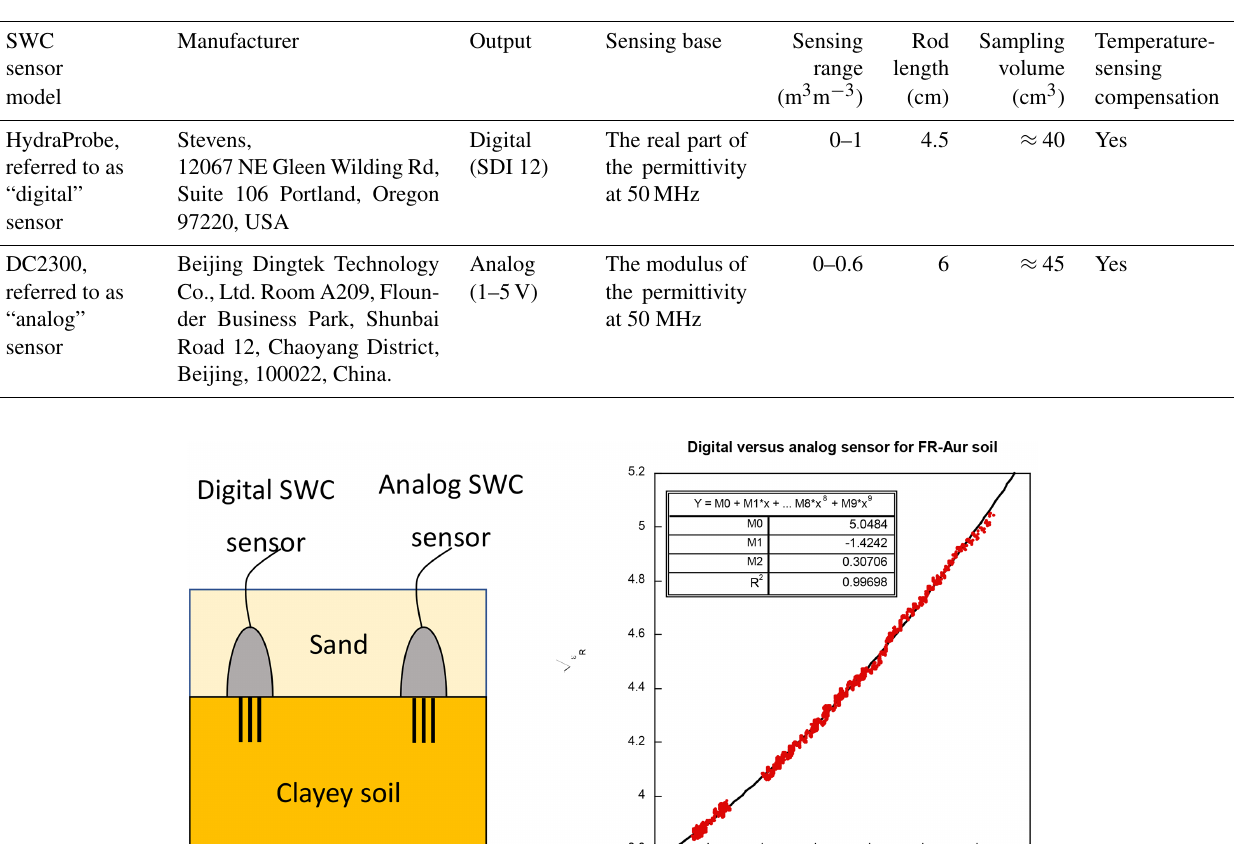
Table 2. SWC sensors specifications.